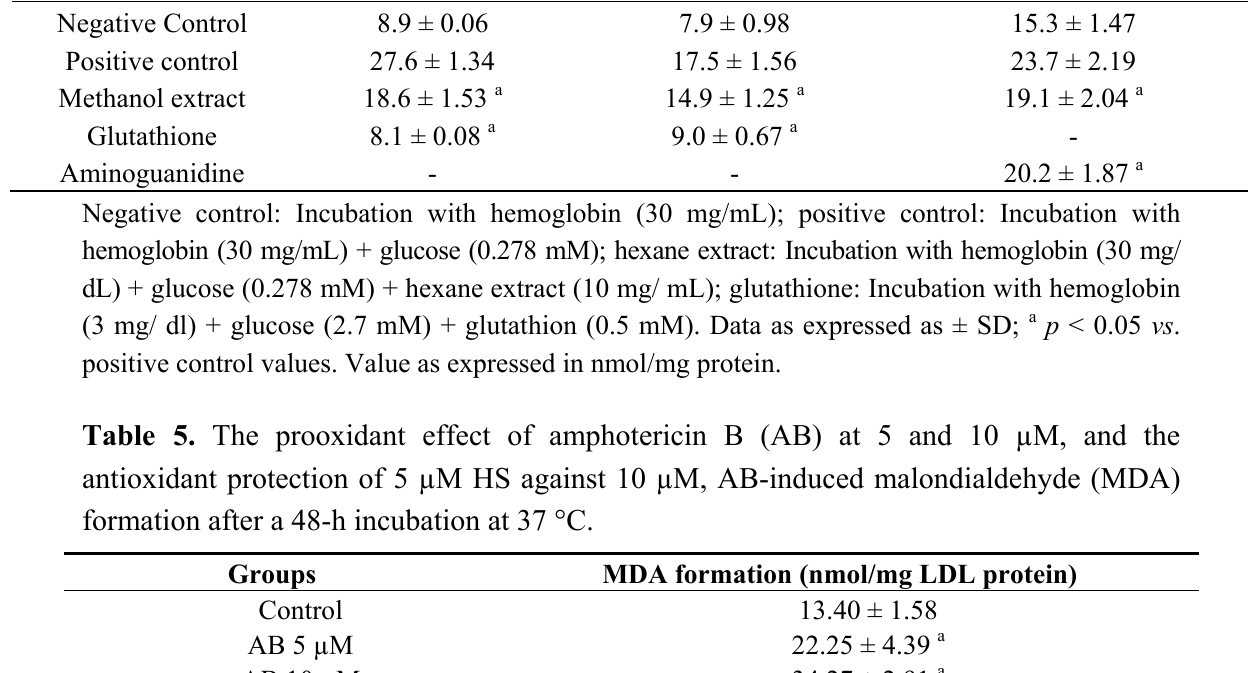
Table 4. Effects of administration of hexane extract of HS on glycosylated protein and glycated, hemoglobin GHb and HbA